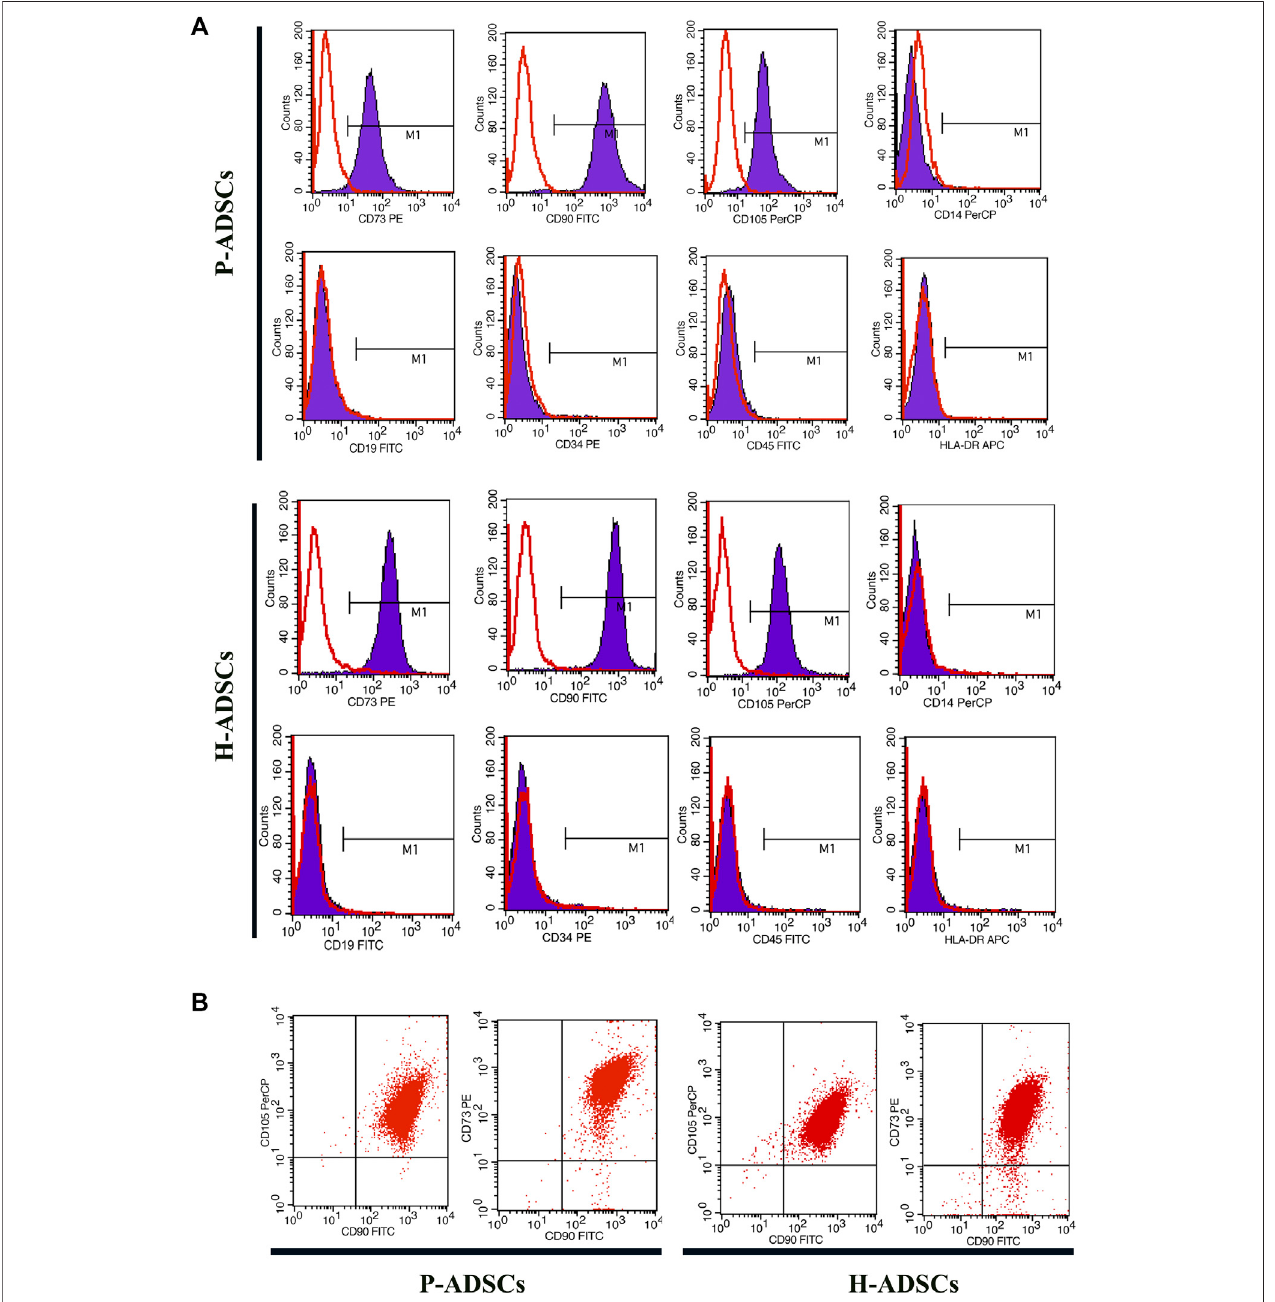
FIGURE 2 | Comparison of phenotypic expansion in P-ADSCs and H-ADSCs (A) : Histogram plots showing the surface positive marker panel (CD73, CD90, and CD105) and negative marker panel (CD14, CD19, CD34, CD45, and HLA-DR). Representative images are shown (B) : Dot plot showing CD73/CD90 and CD90/CD105 staining. Representative images are